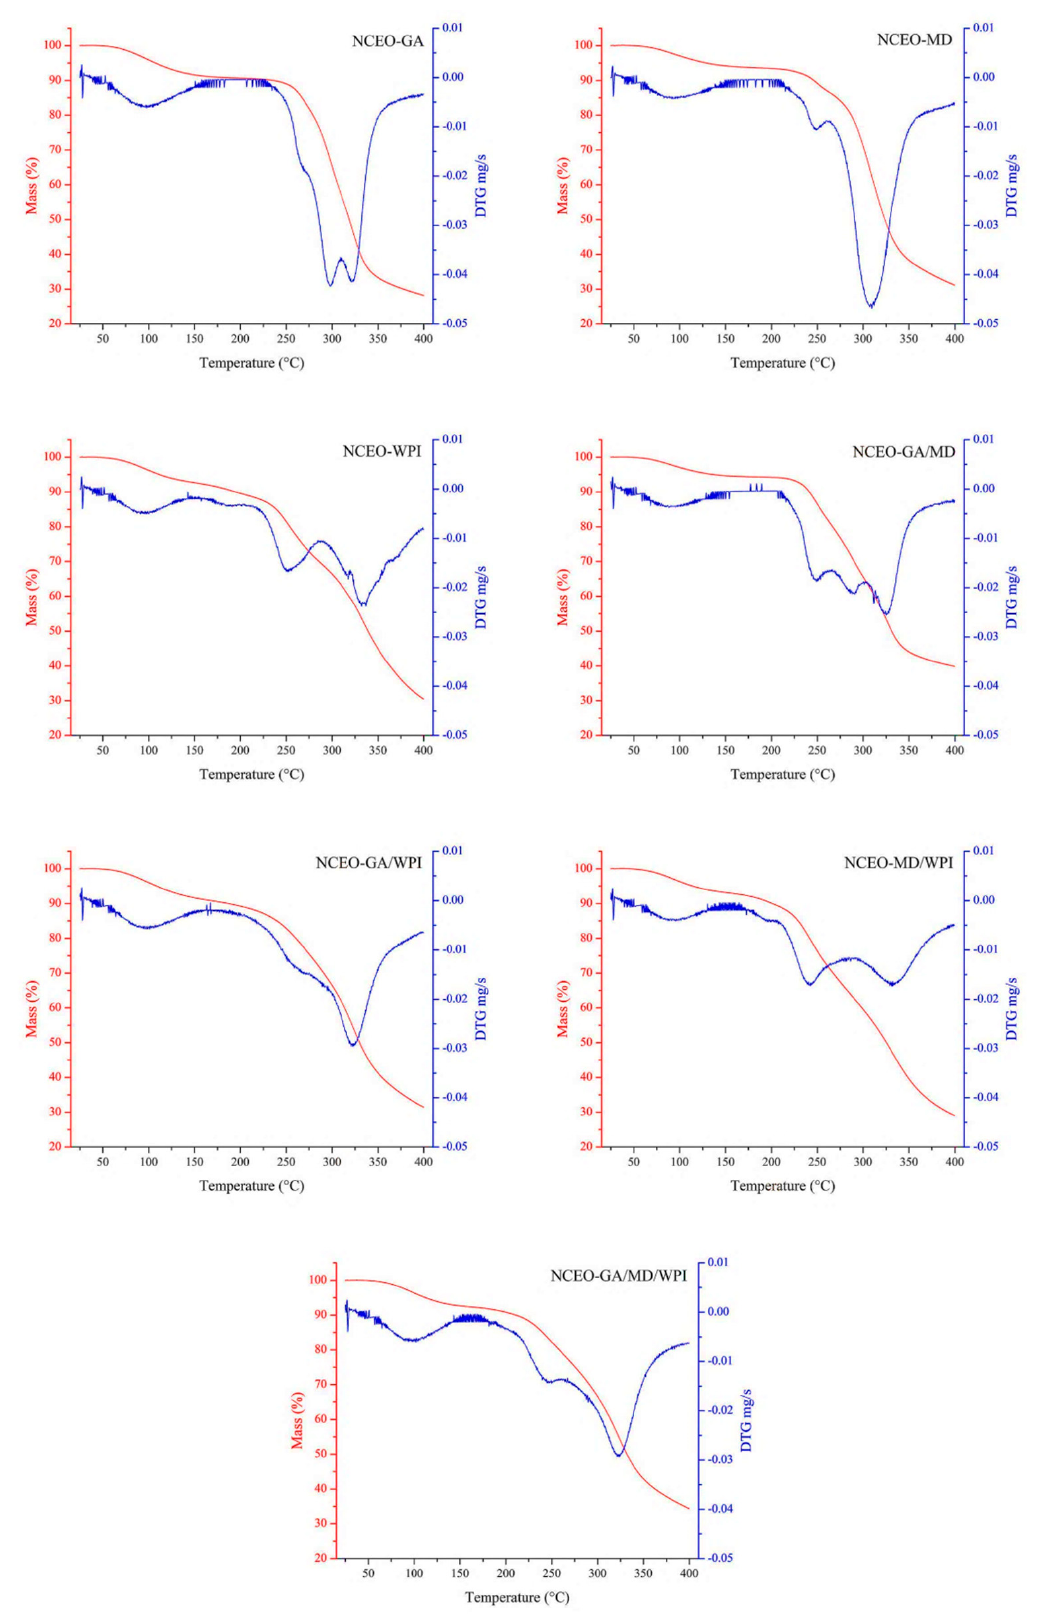
Figure 1. TG and DTG curves of the CEO nanocapsules. The NCEO-GA formulation, according to the DTG curves, presented four thermal decomposition stages, with temperature peaks (T peak ) at 96.33 °C, 267.67 °C, 297.33 °C, and 321.33 °C. The NCEO-MD formulation had three stages, with T peak at 90.30 °C, 248.67 °C, and 308.33 °C. The NCEO-WPI formulation presented four stages, with T peak at 93.00 °C, 251.67 °C, 316.67 °C, and 332.67 °C. Four stages, with T peak at 90.67 °C, 248.66 °C, 290.00 °C,